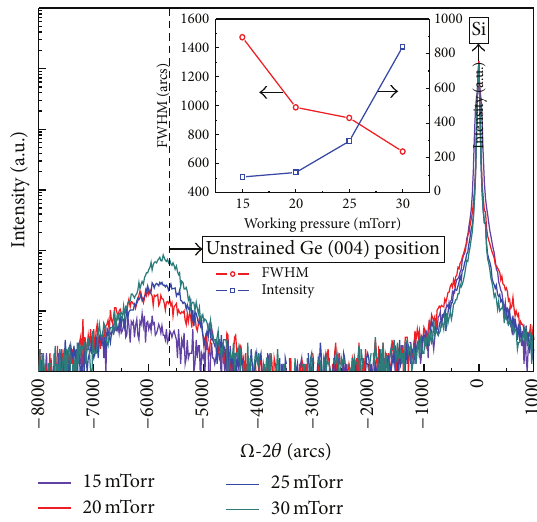
Figure 5: High resolution XRD rocking curve of the Ge (004) peak with various working pressures. The dash line is the position of unstrained Ge (004) position calculated by Bragg’s law. The inset shows the peak intensity and full width at half maximum of the Ge (004) peak from XRD patterns.